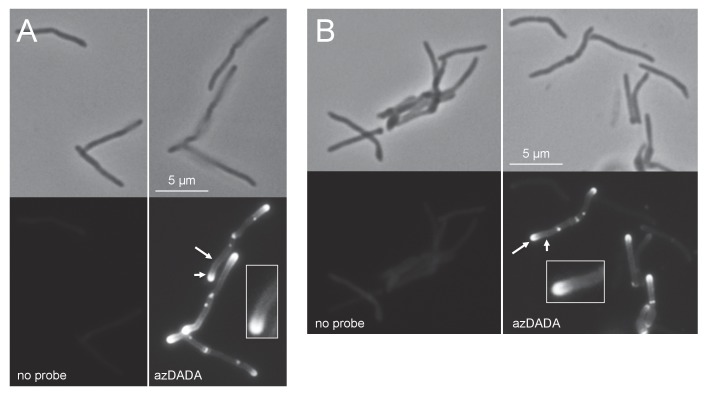
Metabolic labeling by azDADA comprises polar gradients in live M. smegmatis.Bacteria were labeled with azDADA for 15 min and subjected to either A, low copper CuAAC (with BTTP ligand), or B, SPAAC. Longer arrow, polar labeling. Short arrow, sidewall labeling.10.7554/eLife.37243.005Figure 2—figure supplement 1—source data 1.Conventional fluorescence microscopy images of AzDADA-labeled M. smegmatis revealed by SPAAC or CuAAC.